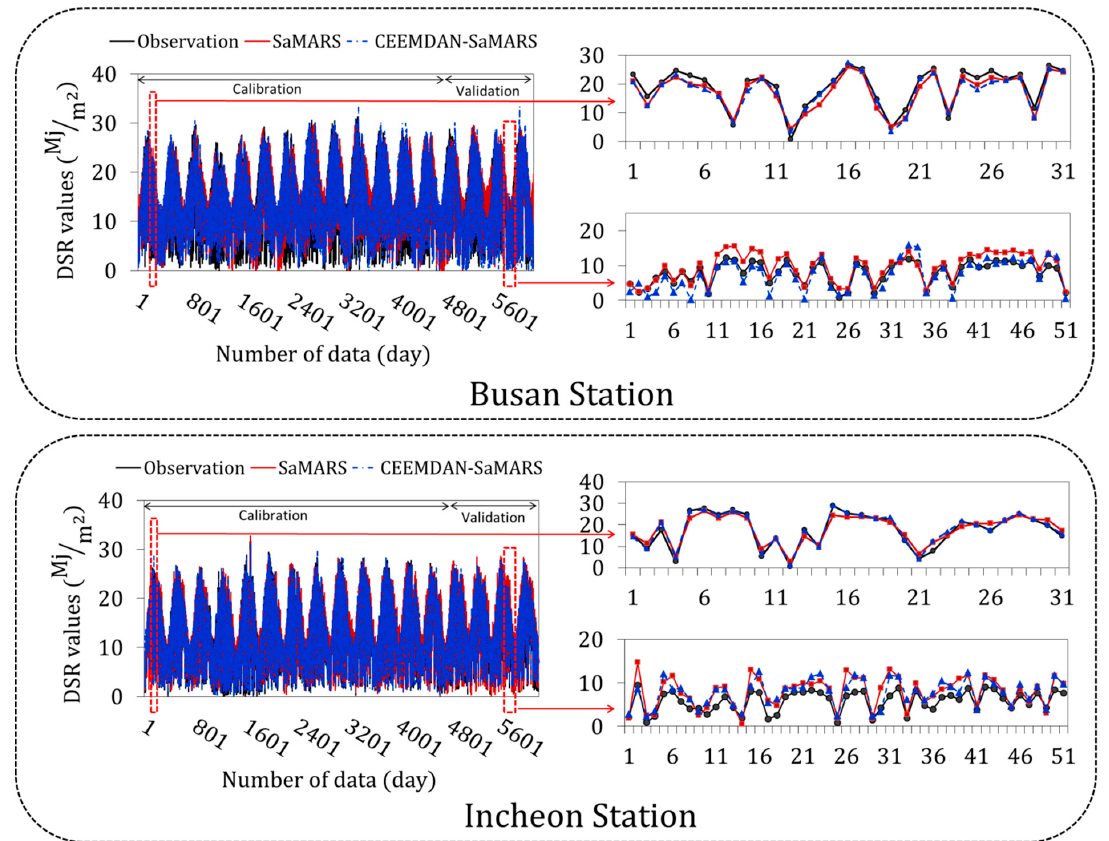
Figure 9. Time-series plots between observed and forecasted DSR for SaMARS and CEEMDAN- Figure9. Time-seriesplotsbetweenobservedandforecastedDSRforSaMARSandCEEMDAN-SaMARS SaMARS models for the calibration and validation phases at Busan and Incheon stations. models for the calibration and validation phases at Busan and Incheon